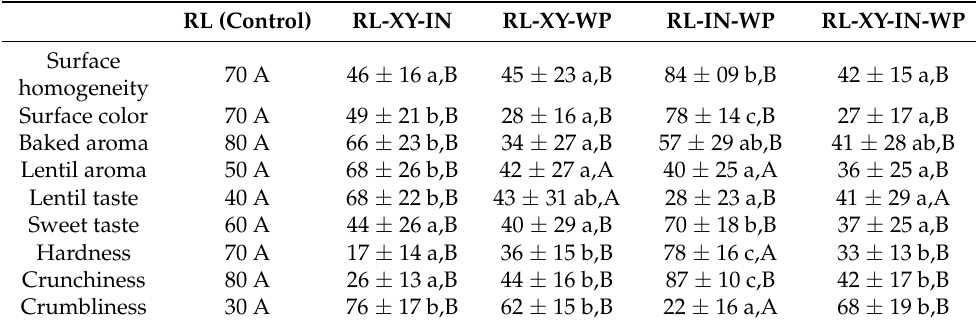
Table 9. Sensory properties of red lentil